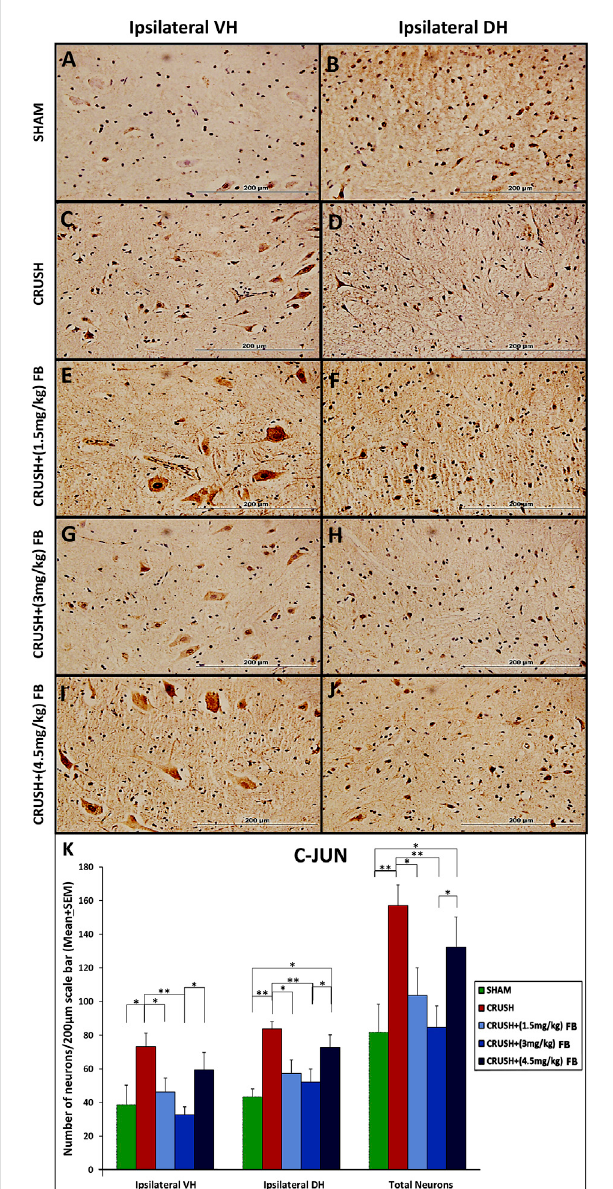
FIGURE 7 (A – J) : c-Jun immunoreactive neurons in ipsilateral lumbar spinal cord segments following sciatic nerve crush injury. C-Jun-positive neurons were observed with a brown-stained nucleus in the ipsilateral ventral and dorsal grey horns (magni fi cation ×40). (K) Number of c-Jun-positive neurons at week 4 after sciatic nerve crush surgery. The numbers of c-Jun-positive neurons increased signi fi cantly in the spinal cord ’ s ventral and dorsal horns in all the experimental groups following sciatic nerve crush injury compared with those in the sham-operated group. Data are expressed as mean ± SEM. * p < 0.05, ** p < 0.01, and *** p <